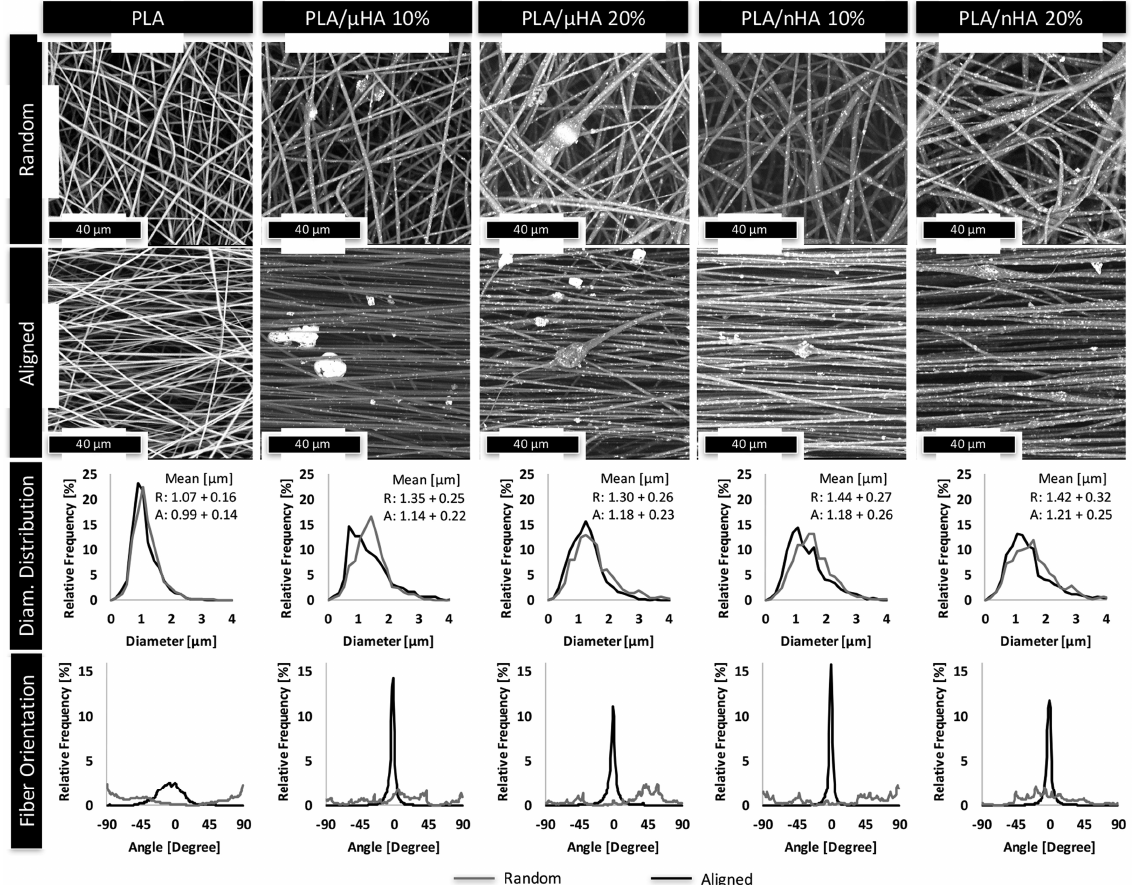
Figure 7. SEM micrographs of random and aligned electrospun mats at different µ HA and nHA concentrations and their corresponding fiber diameter and fiber orientation distribution